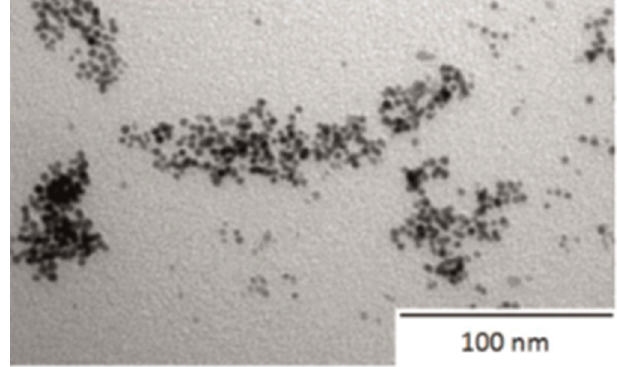
Figure 6. Transmission electron microscopy (TEM) image of AgNPs sputtered into glycerol [74].